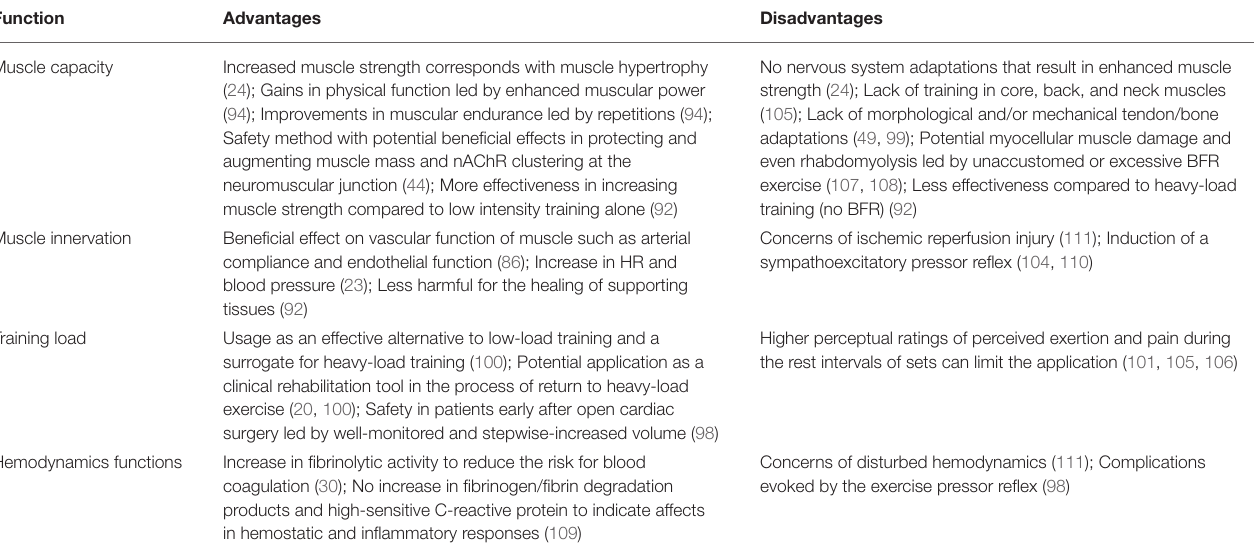
TABLE 1 | The advantages and disadvantages reported in sarcopenia. Function Advantages Disadvantages Muscle